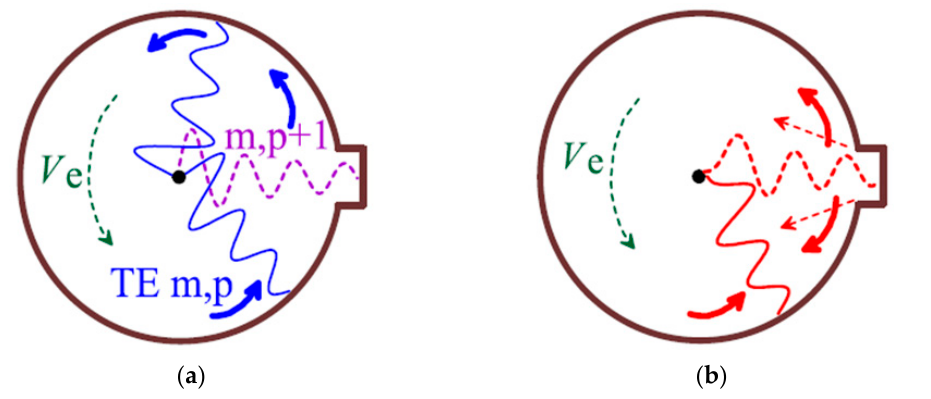
Figure 15. Cross-section of a cavity with one azimuthal inhomogeneity: ( a ) rotating operating wave and ( b ) transformation of rotating parasitic wave. and ( b ) transformation of rotating parasitic